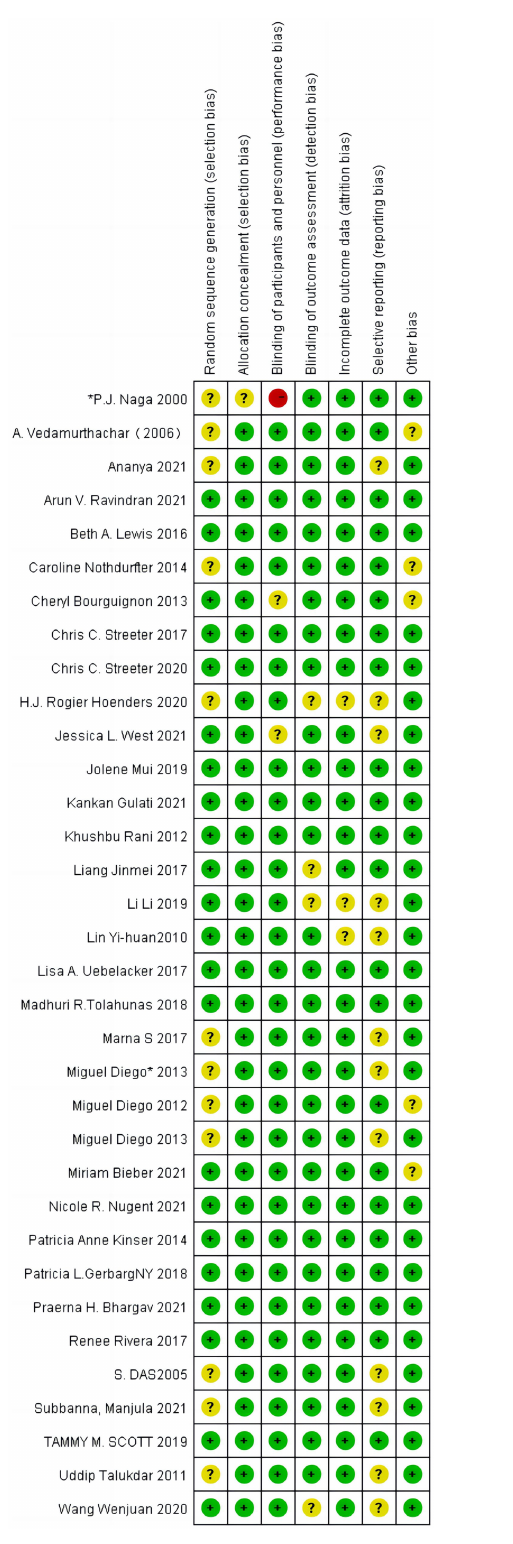
FIGURE 2 Risk of bias summary: a review of the authors’ judgments about each risk of bias item for each included